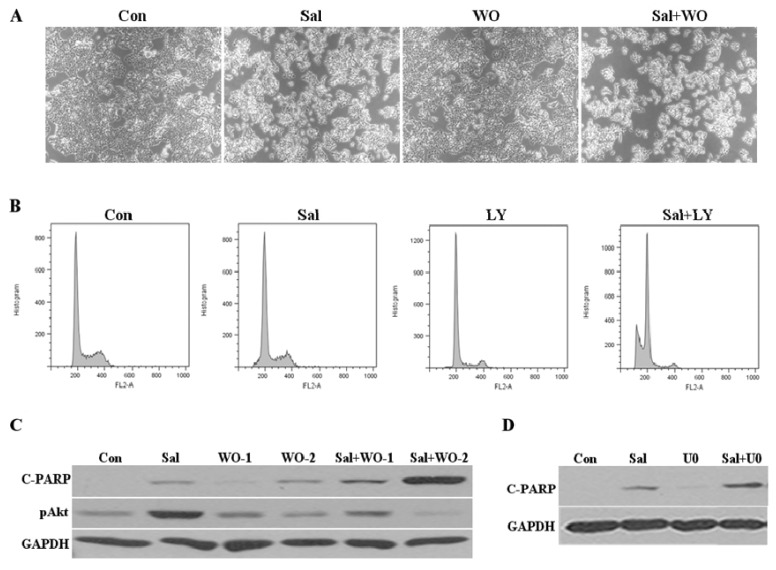
Co-treatment with Akt inhibitor sensitizes Sal-treated cells. (A) Hs578T cells were grown on 6-well plates and treated for 48 h with 0.5 μM Sal (Sal), 1 μM wortmannin (WO), 0.5 μM Sal with 1 μM wortmannin (Sal + WO) or DMSO (Con). After 48 h, all cells were observed using an inverted microscope with a 5× objective lens. (B) Hs578T cells were grown on 6-well plates and treated with 0.5 μM Sal (Sal), 20 μM LY294002 (LY), 0.5 μM Sal with 20 μM LY294002 (Sal+LY), or DMSO (Con). After 72 h, FACS analysis was performed as described in the Materials and methods. (C) Hs578T cells were grown on 6-well plates and treated for 48 h with 0.5 μM Sal (Sal), 1 μM wortmannin (WO-1), 2 μM wortmannin (WO-2), 0.5 μM Sal with 1 μM wortmannin (Sal + WO-1), 0.5 μM Sal with 2 μM wortmannin (Sal + WO-2), or DMSO (Con). After 48 h, the cells were used for western blot analysis using antibodies against C-PARP, pAkt, and GAPDH. (D) Hs578T cells were plated on 6-well plates and grown to 30%–40% confluence. The cells were then stimulated for 24 h with 0.5 μM Sal (Sal), 10 μM U0126 (U0), 0.5 μM Sal with 10 ìM U0126 (Sal + U0), or DMSO-treated (Con).